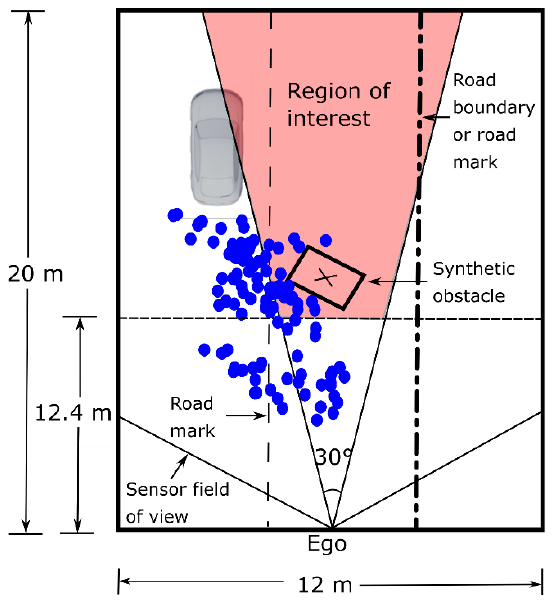
Figure 2. Region of interest. The size is based on the region in which spray is usually detected [10] for the LIDAR and speeds used. Before 12.4 m, even if a solid object is detected no meaningful action can take place. The 30° are based on the curve radii found in European roads. The ‘x’ marks the center of the added synthetic object.